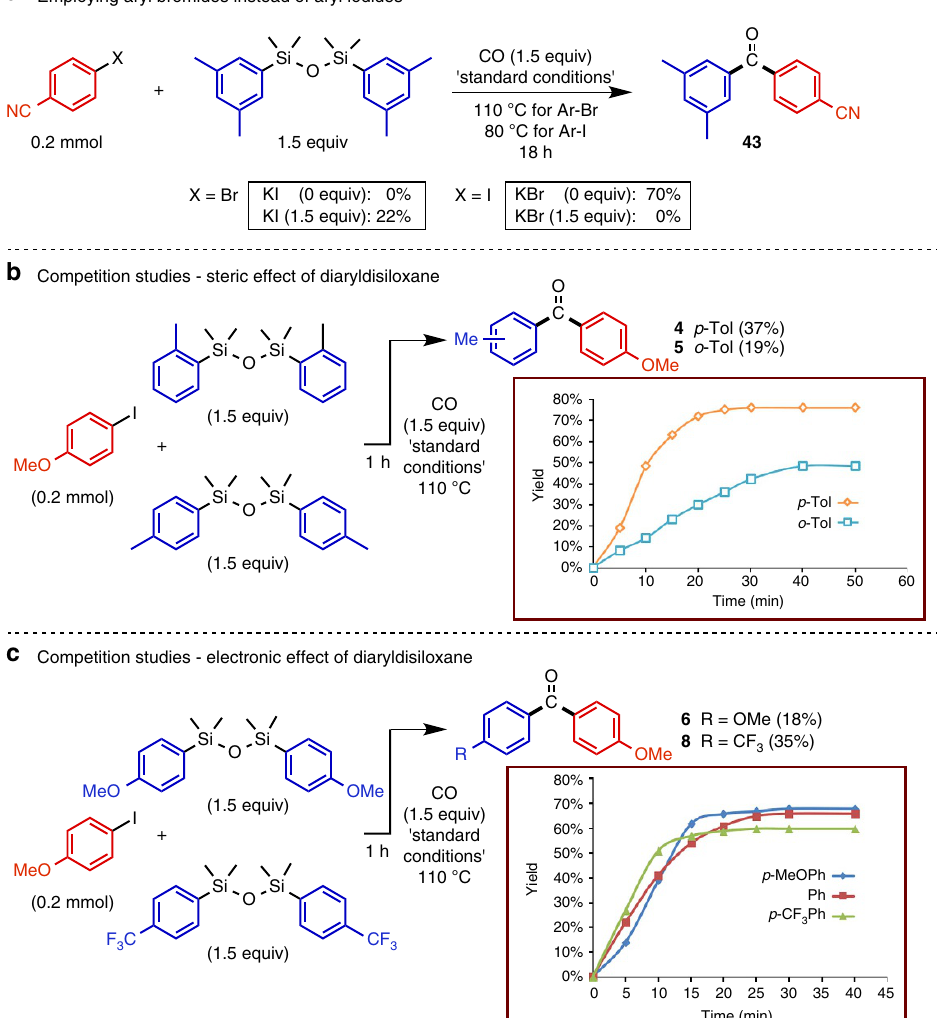
Figure 4 | Substrate effects in the carbonylative Hiyama-Denmark coupling. ( a ) Comparative coupling studies with an aryl bromide and iodide, and the effect of the addition of halide salts such as potassium bromide (KBr) and potassium iodide (KI) on the coupling efficiency. ( b ) The effect of substituent position on the diaryldisiloxane in both a competitive reaction whereby 1.5 equivalents of each disiloxane were reacted simultaneously with p -iodoanisole. The yields were determined after 1h of reaction. A similar ratio between the two coupling products was obtained after 30min of reaction. In addition, the individual reactions were also tested (boxed graph) starting from the corresponding disilanes and CO 2 . ( c ) A similar set of experiments as in B was carried out between an electron rich and electron poor diaryldisiloxane. The yields depicted in the graphs are based on GC using trimethoxybenzene as the internal